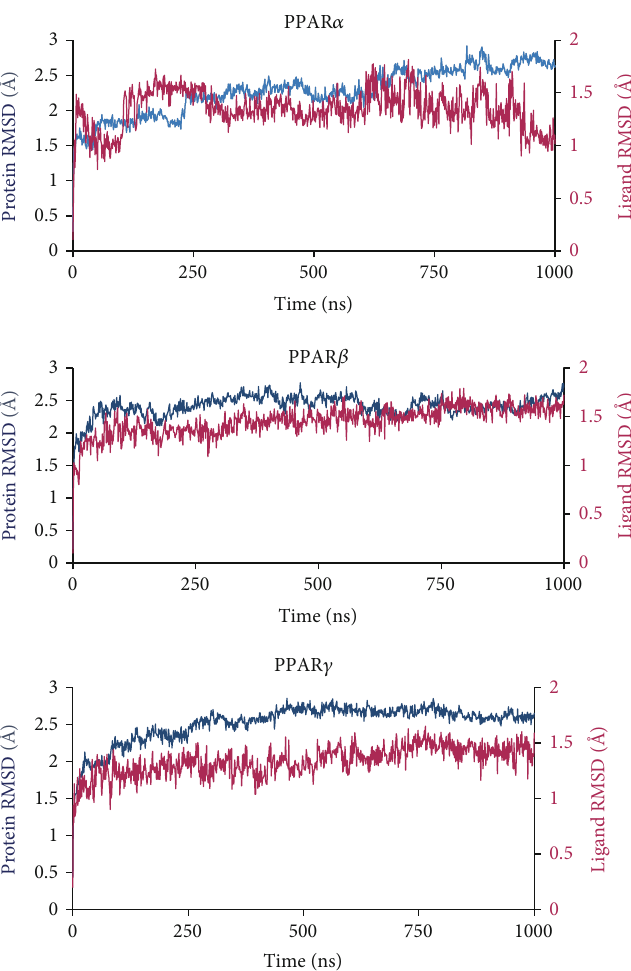
Figure 4: Average root mean square deviation (RMSD) plot for the three MD simulation runs of each protein-ligand complex over the length of the trajectory. The C α -RMSD for the protein (shown in blue) and ligand RMSD (shown in red) is based on the initial protein